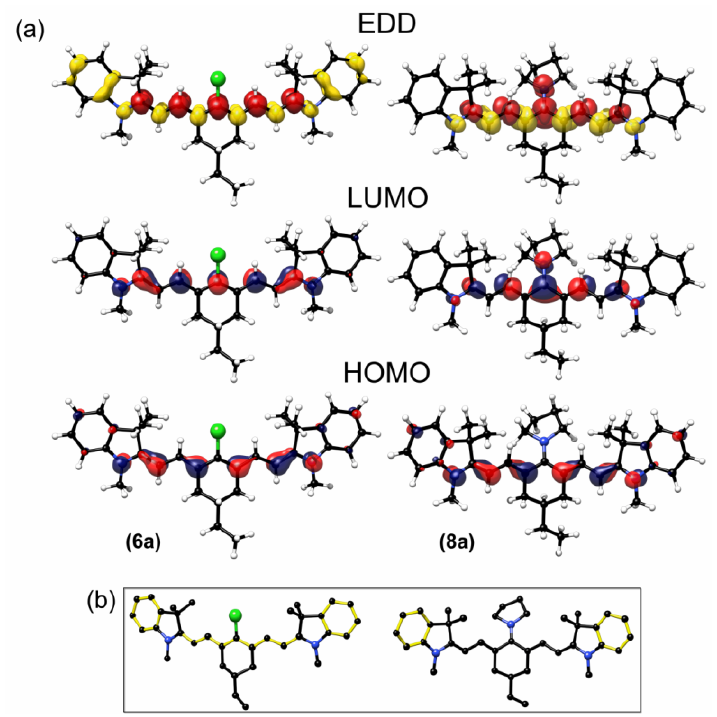
Figure 7. ( a ) Electronic Density Difference (EDD) with isosurface = 0.0016 for cyanine dyes 6a and 8a . The red color indicates a vertical charge increase and the yellow indicates avertical charge decrease for the GS-ES transition. HOMO and LUMO orbitals have isosurface = 0.05 with the (+) phase color coded as red and the ( − ) phase as blue. ( b ) Bonds with strong delocalized character (yellow) calculated by the Pipek–Mezey method. Hydrogens were omitted for clarity.